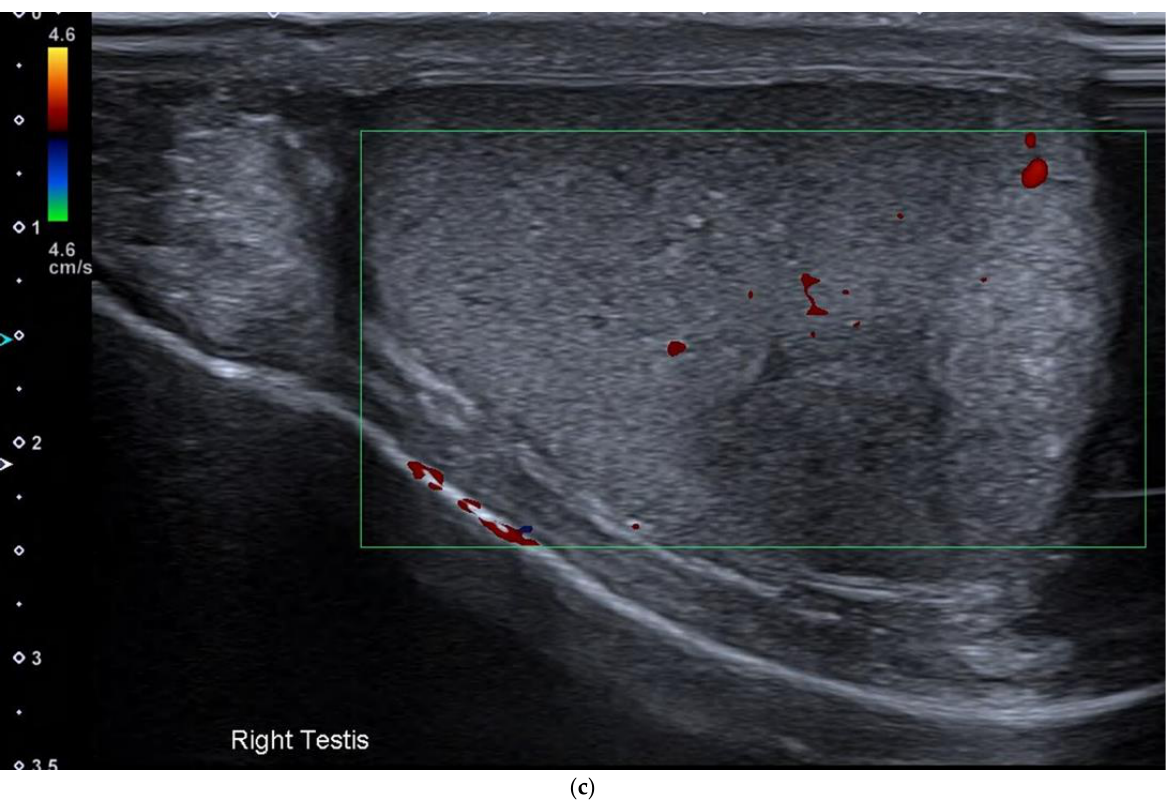
Figure 8. ( a ) Axial slice from CT KUB in a 35-year-old patient who presented with acute right flank pain demonstrates large retroperitoneal nodal disease. ( b ) Coronal image from contrast CT shows large nodal disease causing right hydronephrosis, deviation of the aorta and a solitary liver metastasis. ( c ) Colour Doppler ultrasound from the same patient shows a solitary lesion in the right testis in keeping with a primary testicular tumour.